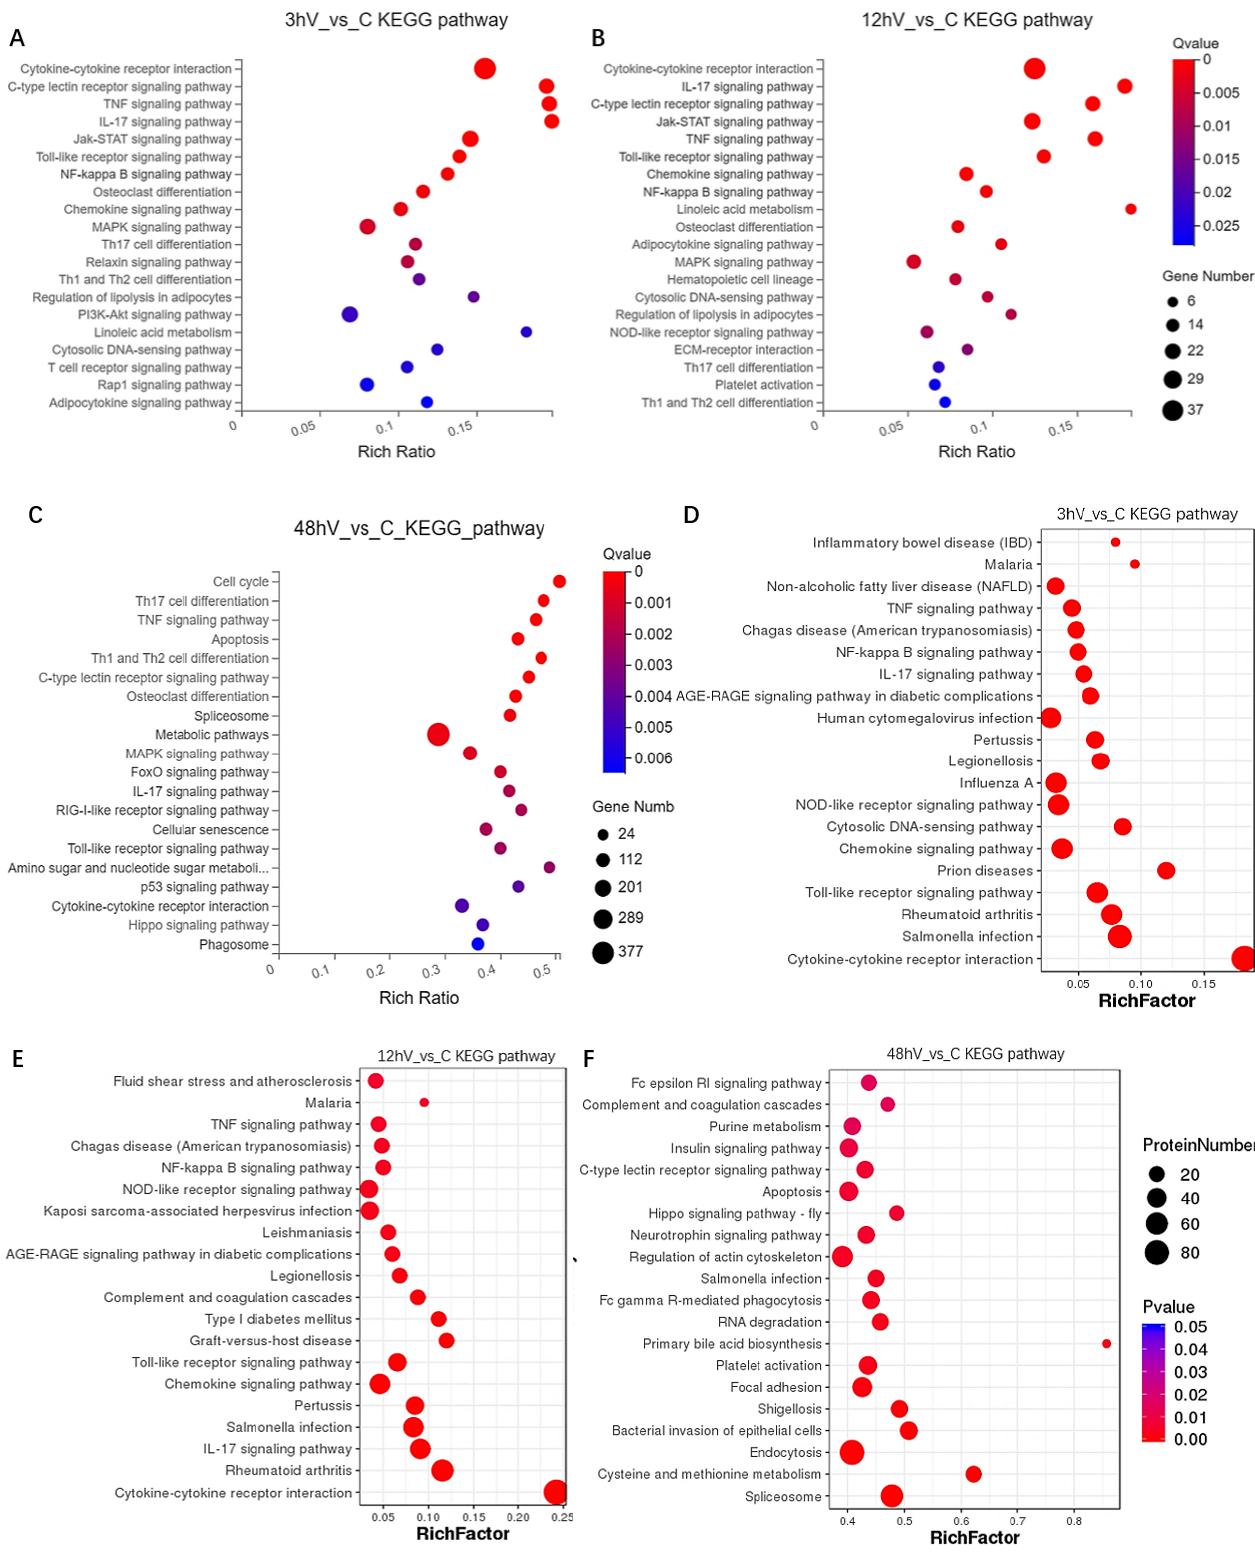
Figure 3. KEGG pathway enrichment analysis of DEGs and DEPs. Differentially expressed genes ( A – C ) and differentially expressed proteins ( D – F ) at the three time points of ASFV infection were annotated using KEGG pathway enrichment analysis.